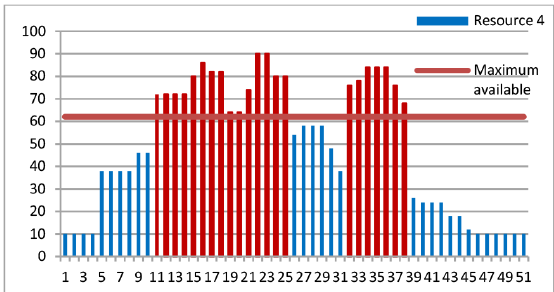
Figure 50. Daily usage of resource 3 throughout the calendar of the project (before using the method)-Experiment 3